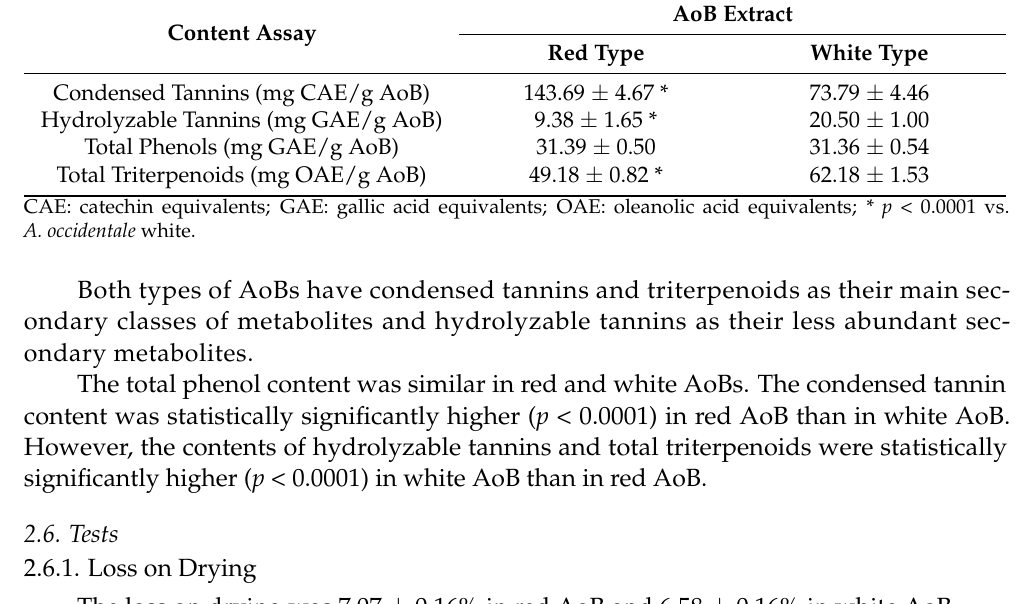
Table 4. Spectrophotometry quantification of secondary metabolites on A. occidentale stem barks. AoB Extract Content Assay Red Type White Type Condensed Tannins (mg CAE/g AoB) 143.69 ± 4.67 * 73.79 ± 4.46 Hydrolyzable Tannins (mg GAE/g AoB) 9.38 ± 1.65 * 20.50 ± 1.00 Total Phenols (mg GAE/g AoB) 31.39 ± 0.50 31.36 ± 0.54 Total Triterpenoids (mg OAE/g AoB) 49.18 ± 0.82 * 62.18 ±